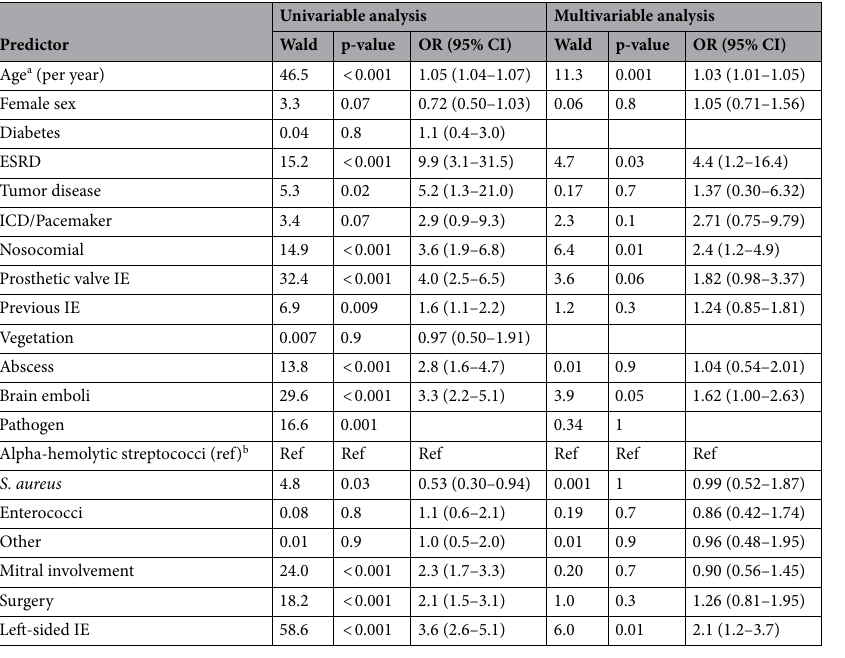
Table 3. Univariable and multivariable Cox regression for predictors of long-term survival in patients with left-sided and right-sided IVDU associated IE. Diabetes includes both type 1 and type 2 diabetes mellitus. No patients had a background of ESRD or tumor disease in right-sided IE. Alpha-hemolytic streptococci were used as reference for pathogens. ESRD end-stage renal disease, ICD intra cardiac device, IE infective endocarditis. a Increasing age per 1-year increment. b Alpha-hemolytic streptococci was used as reference in